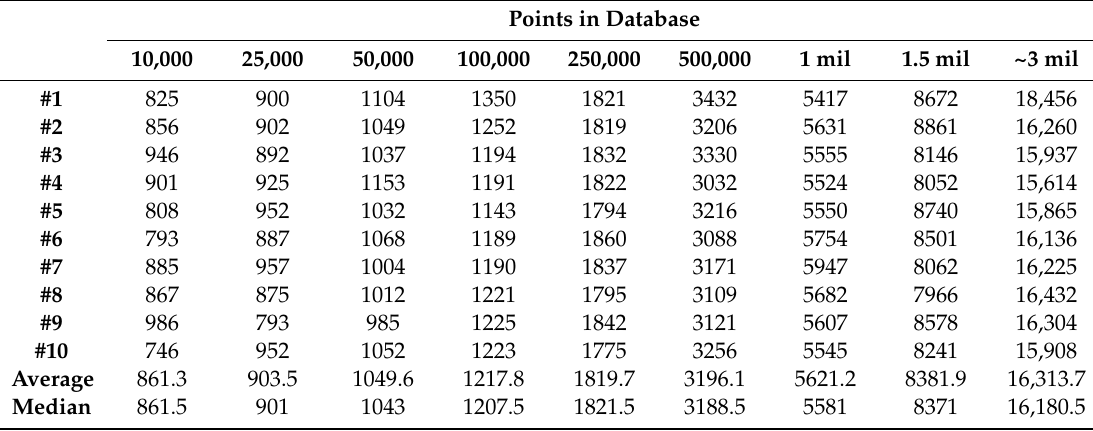
Table 7. Results of testing Leaflet.heat library (values in